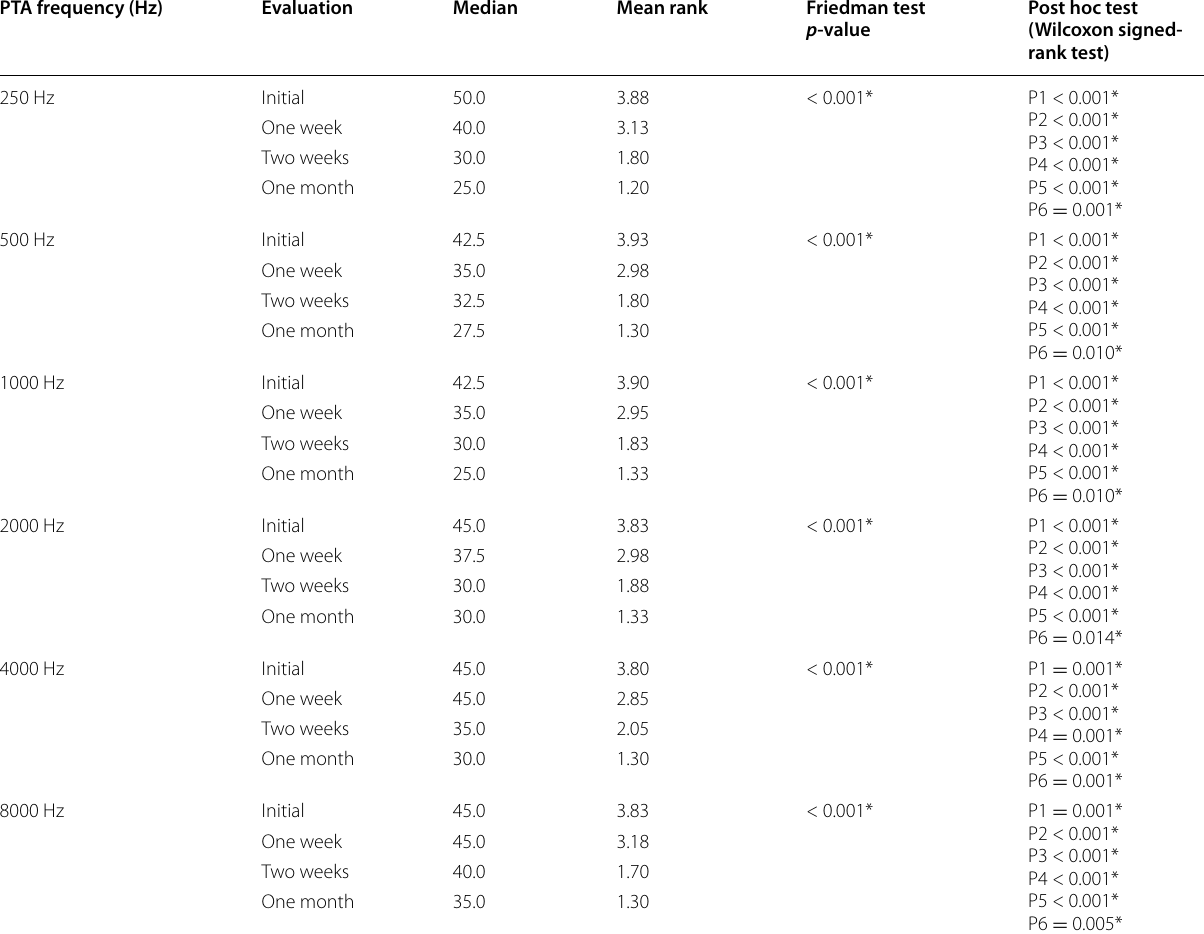
Table 1 Comparison between the values of PTA at different studied time points (initial before starting of treatment, after 1 week, after 2 weeks, and after 1 month of treatment)